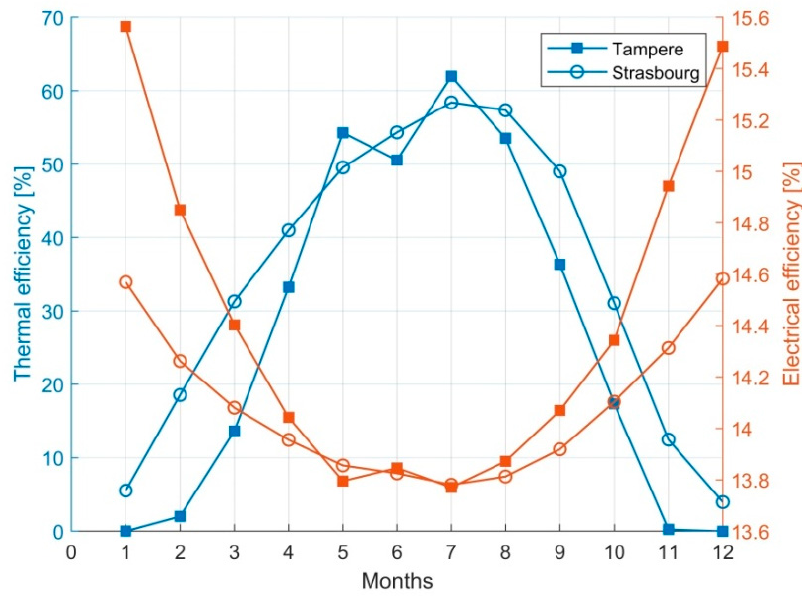
ffi ciencies over year in Tampere and Strasbourg.